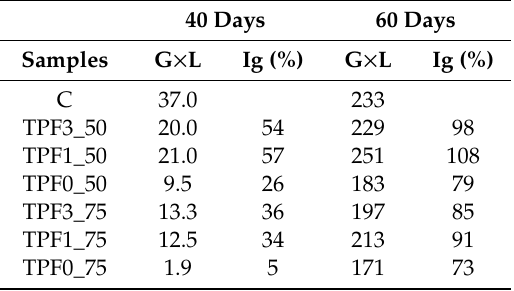
Table 4. Germination test results on compost extract taken 40 and 60 days after the incubation. 40